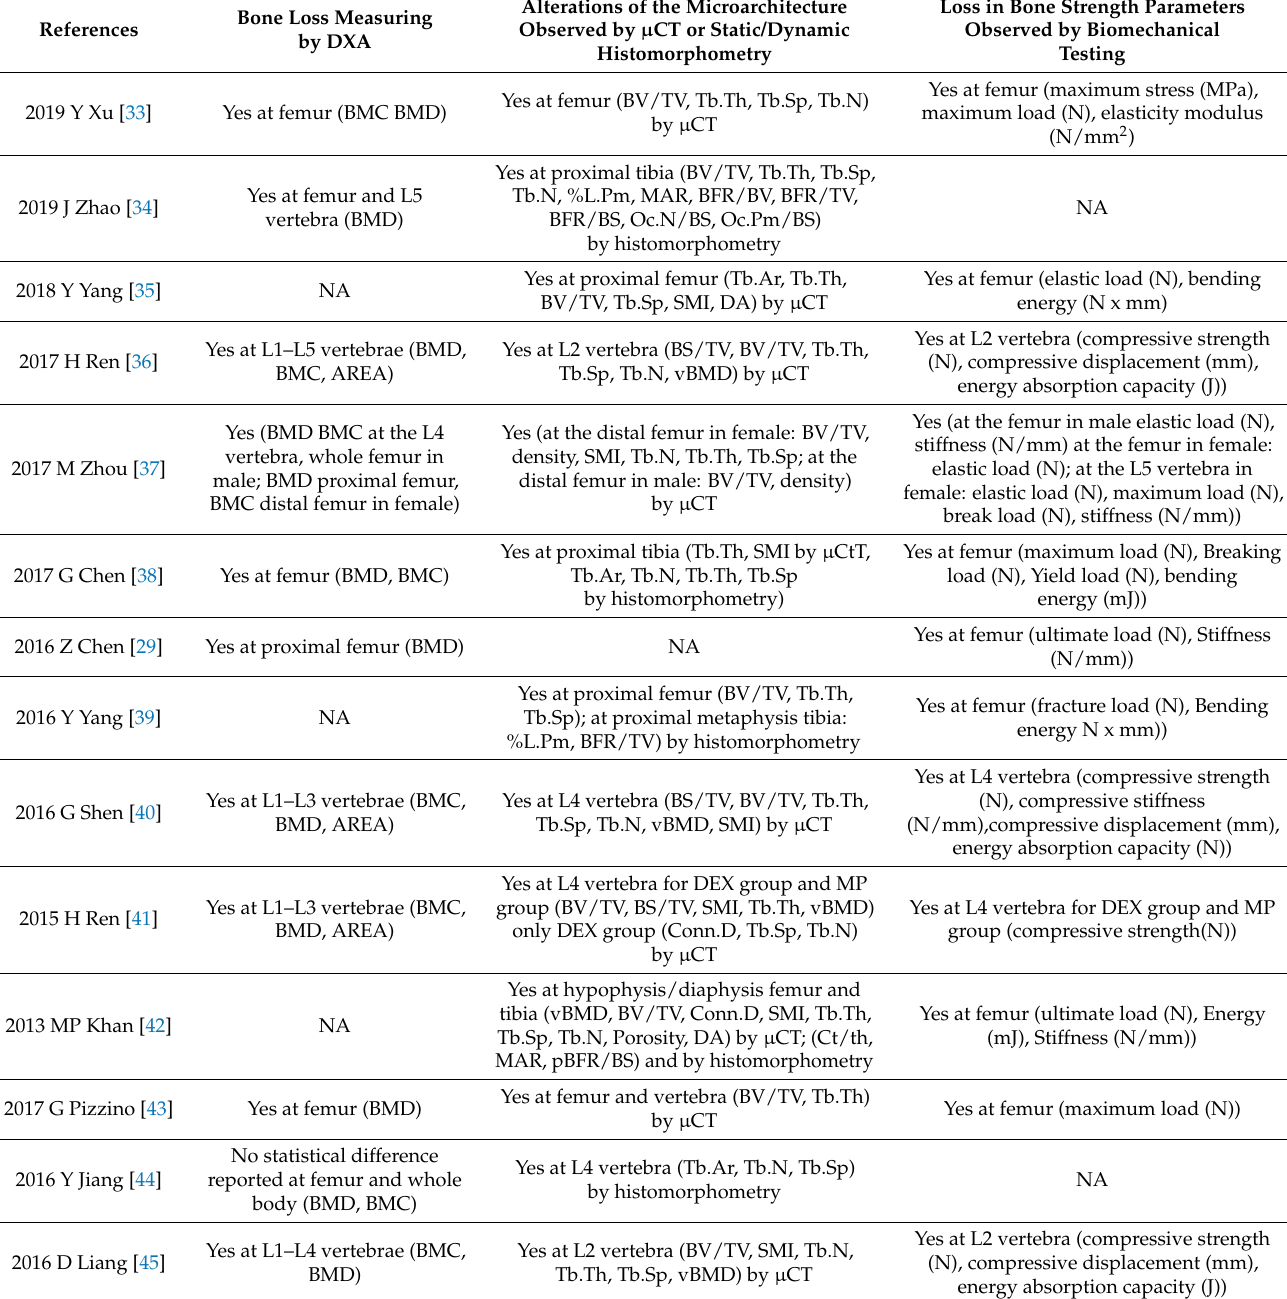
Table 9. Results of bone quality assessments reported by the studies. The DXA parameters are BMD (bone mineral density) and BMC (bone mineral content). The µ CT parameters are BV/TV (bone volume/tissue volume), BS/BV (bone surface/bone volume), Tb.N (trabecular number), and Tb.Th (trabecular thickness), Tb.Sp (trabecular separation), SMI (structure-model index). The used static histomorphometry parameters are: Oc.N/BS (osteoclast number/bone surface), Ob.N/BS (osteoblast number/bone surface), Oc/S/BS (osteoclast surface/bone surface), Ob.S/BS (osteoblast surface/bone surface), ES/BS (eroded surface/bone surface), Oc.Pm/B.Pm (osteoclast perimeter/bone perimeter), Ob.Pm/B.Pm (osteoblast perimeter/bone perimeter), OS/BS (osteoid surface/bone surface). The dynamic histomorphometry parameters are: MS/BS (mineralizing surface/bone surface), MAR (mineral apposition rate), BFR/BS (bone formation rate/bone